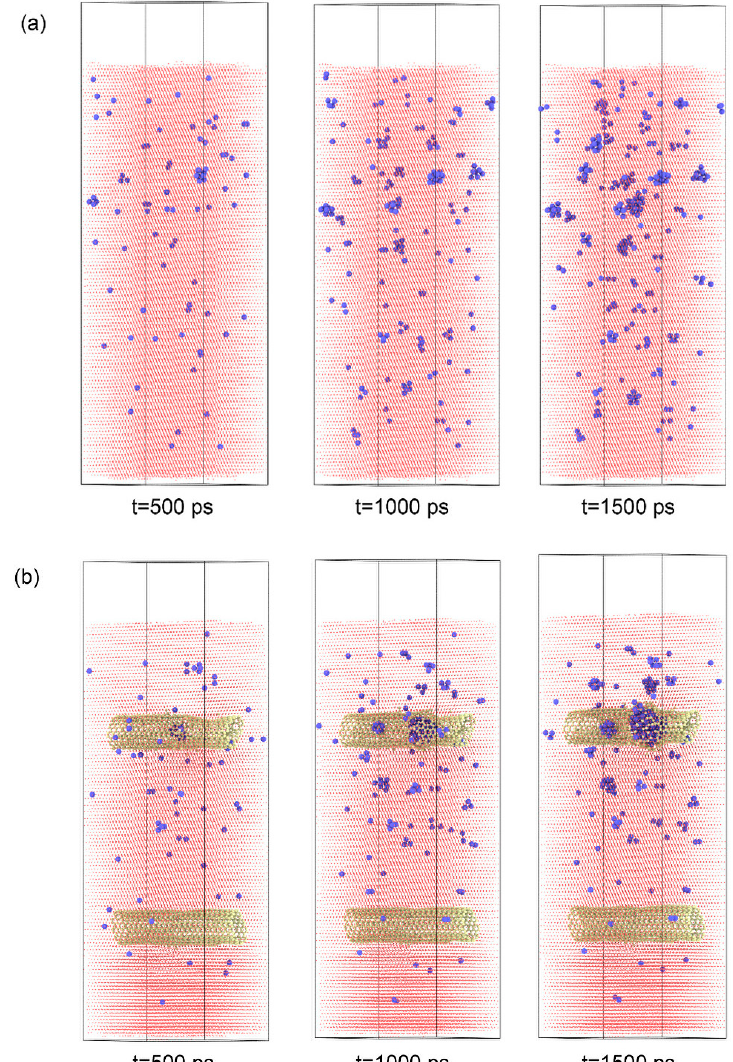
Figure 4. He clusters in the matrix when the incident energy of the He atoms was 600 eV. ( a ) Fe matrix; ( b ) SWCNT/Fe composite. The blue and yellow balls denote He and C atoms, respectively. The number of He clusters in the Fe matrix and the SWCNT/Fe composite at t = 1200 ps are